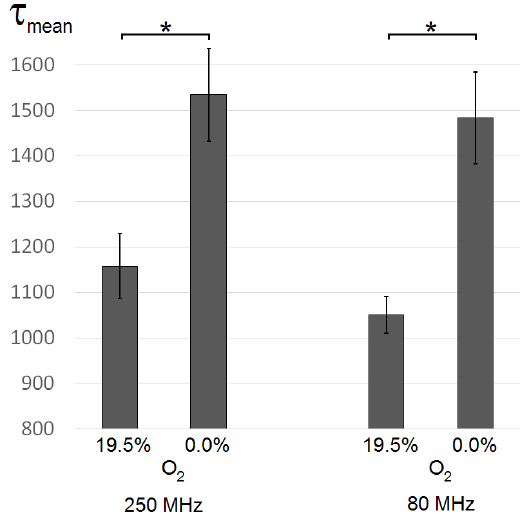
Fig. 4. Statistical evaluation of the phosphorescence lifetime (cid:1) mean of IEC-6 monolayer cells in nanoseconds previously in- cubated with TLD1433 under 19.5% oxygen and under hypoxic (0.0% oxygen) conditions, measured by using two di®erent laser modes: 250 MHz (left) and 80 MHz (right) repetition rate lasers ð (cid:2) p < 0 : 001, n ¼ 18 Þ .